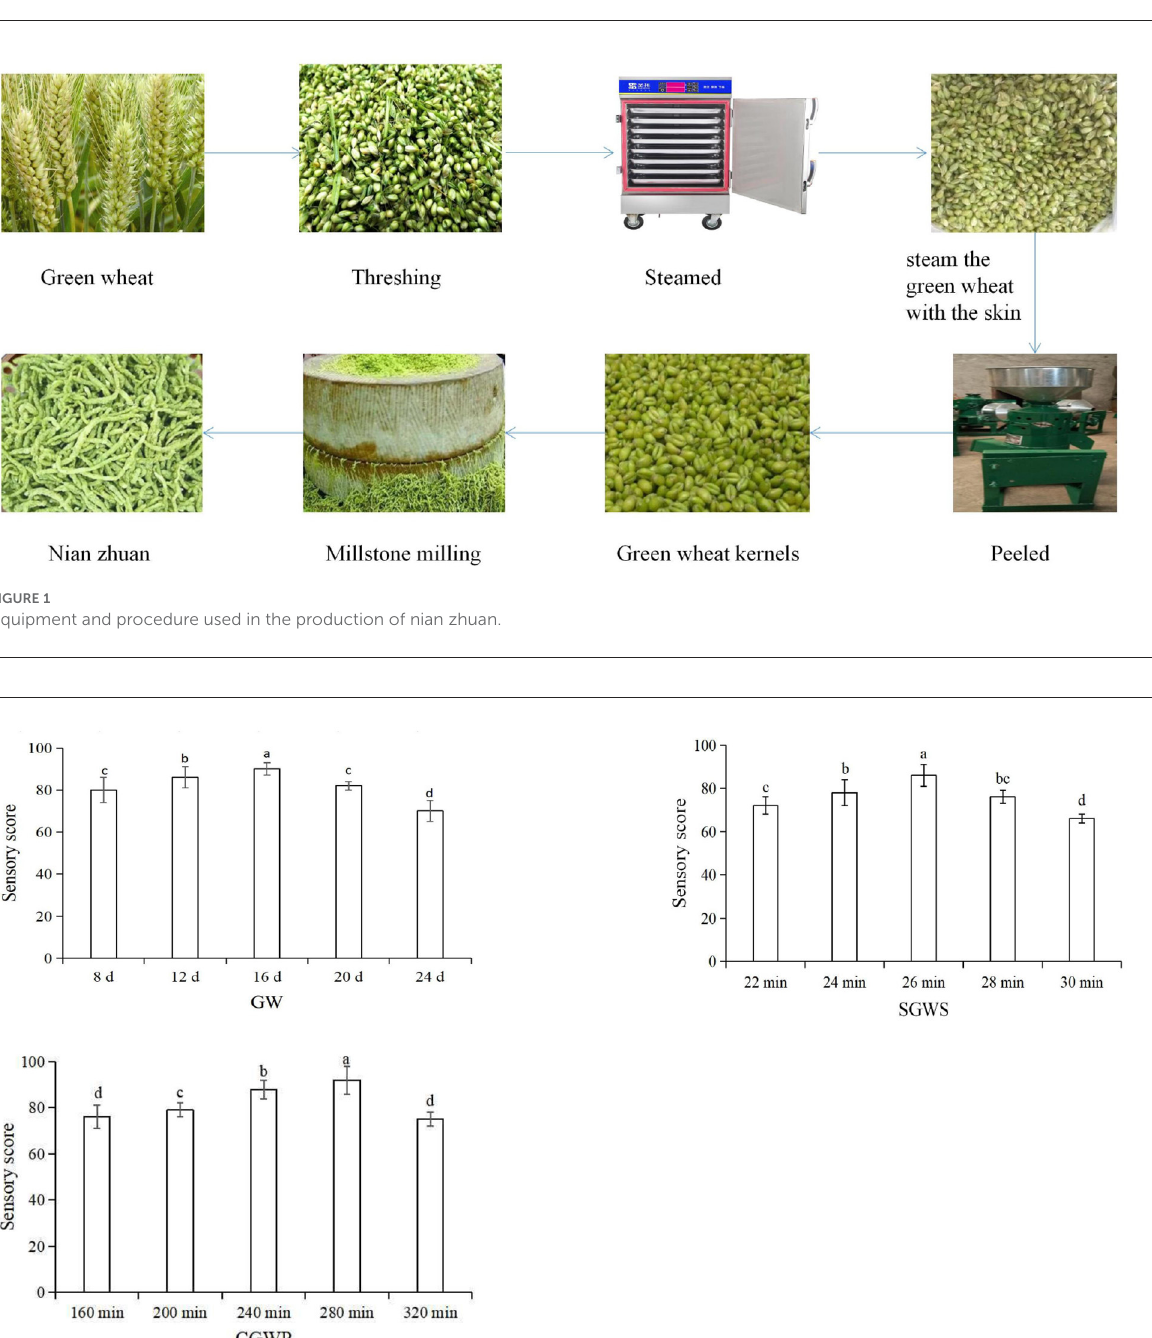
females aged 20–48 years (12). The panelists finished the sensory evaluation in 10 min and rinsed their mouths to refresh the palate with mineral water between samples. The taste, odor, texture, and color of nian zhuan samples were scored by the panelists on the basis of Table